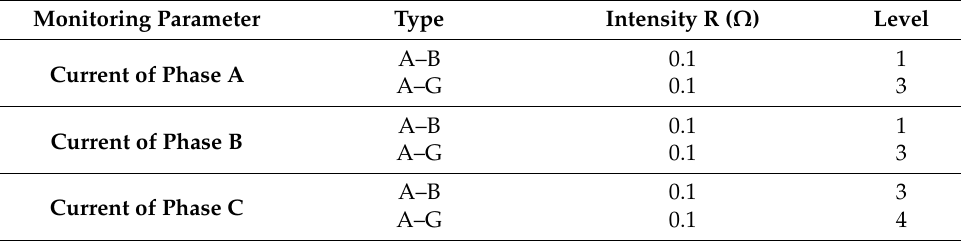
Table 9. Operation with fault at 1.4–1.7 s for ramp load torque and W–N = 60